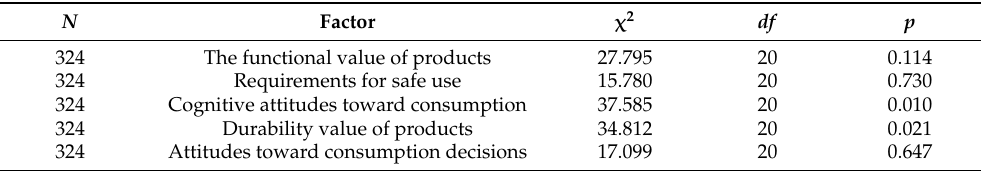
Table 12 details the abstract of Chi-square tests on the dimensions and the average lifespan of toys. Table 12. Abstract of the Chi-square tests on the dimensions and the average lifespan of toys. N Factor χ 2 324